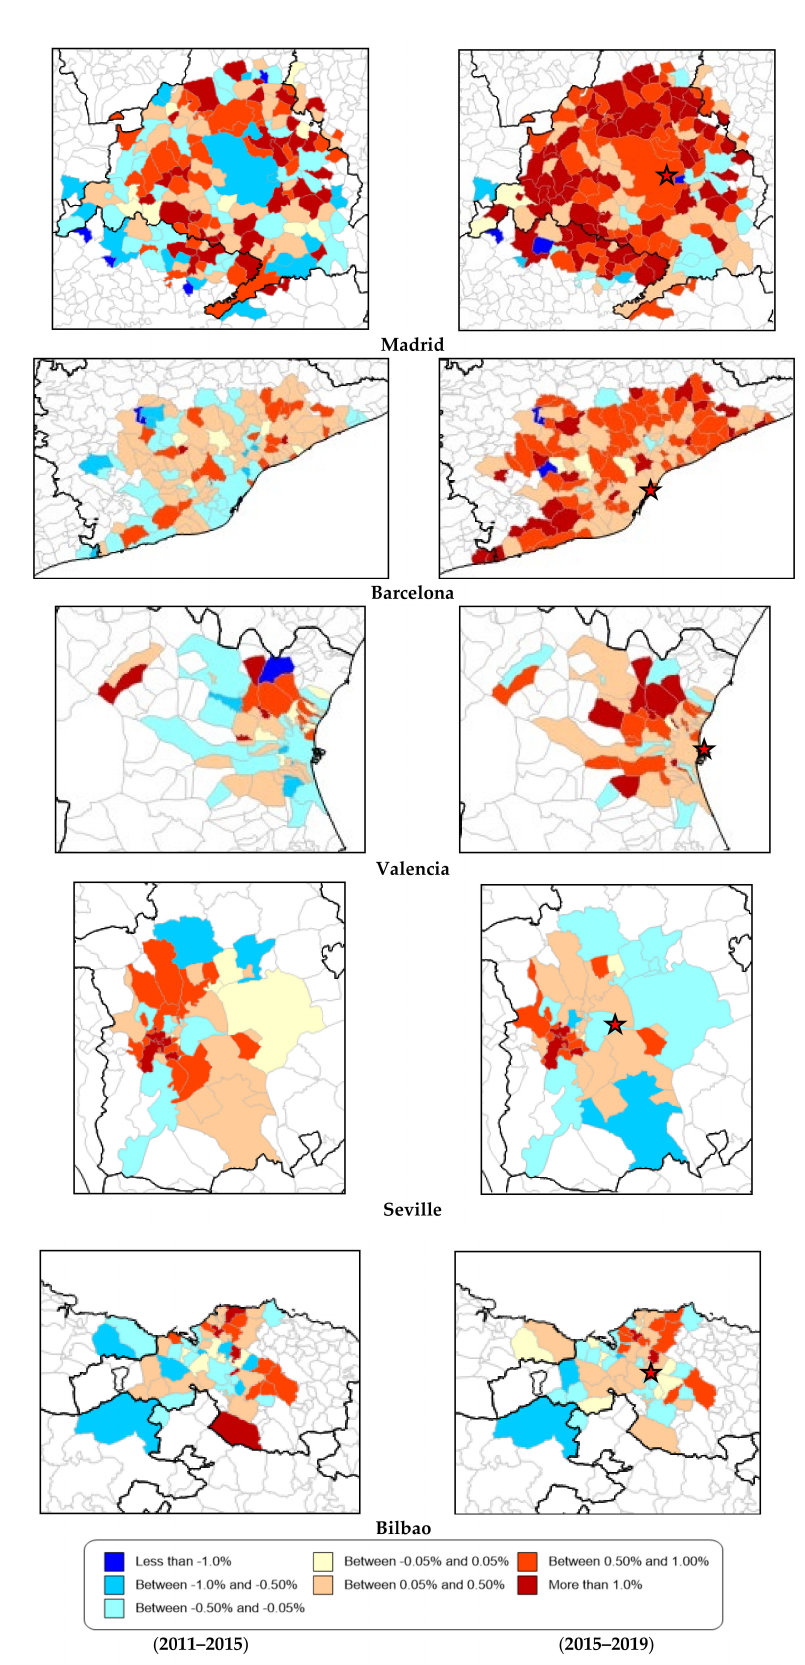
Figure 4. CAGRs by municipality (for each of the five FUAs) in 2011–2015 ( left ) compared to 2015–2019 ( right ). Source: 2011, 2015, and 2019 Padr ó n Continuo (Continuous Population Register) microdata,